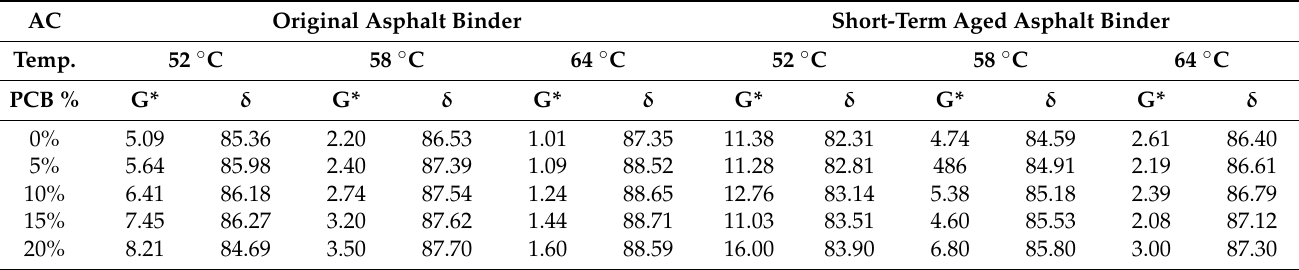
Table 5. Measured shear modulus and phase angle for short-term aged asphalt binder (AP-3).